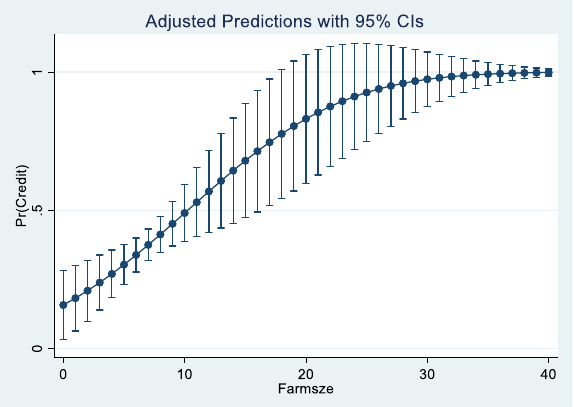
Figure 7. The non-linear impact of farm size on the probability to adopt credit as a risk manage- ment strategy